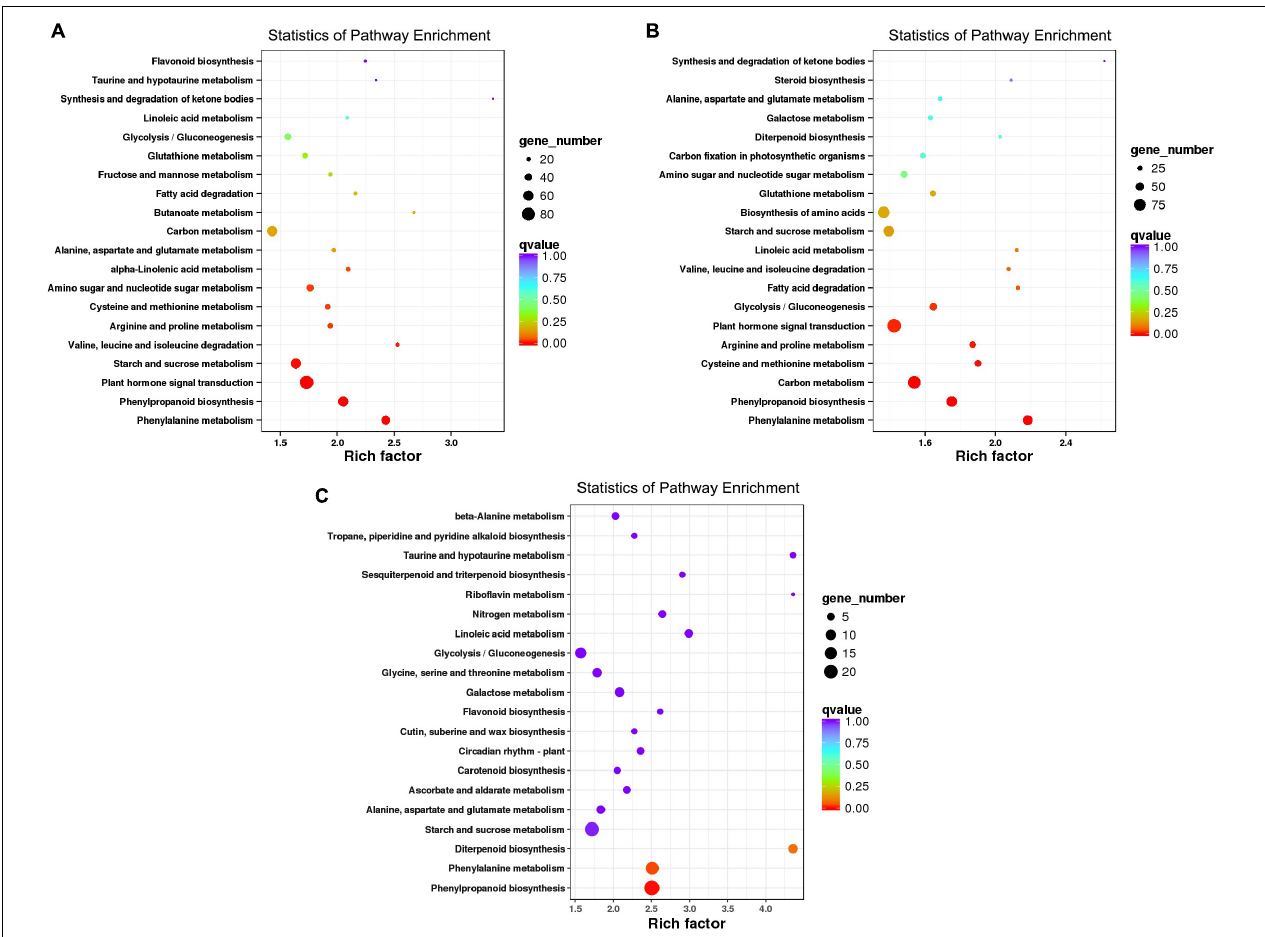
FIGURE 3 | Top 20 enriched pathways analysis. (A) DEGs identified in infected the MR-1 cultivar. (B) DEGs identified in the infected M4-45 cultivar. (C) MR-1 (ACK) vs. M4-45